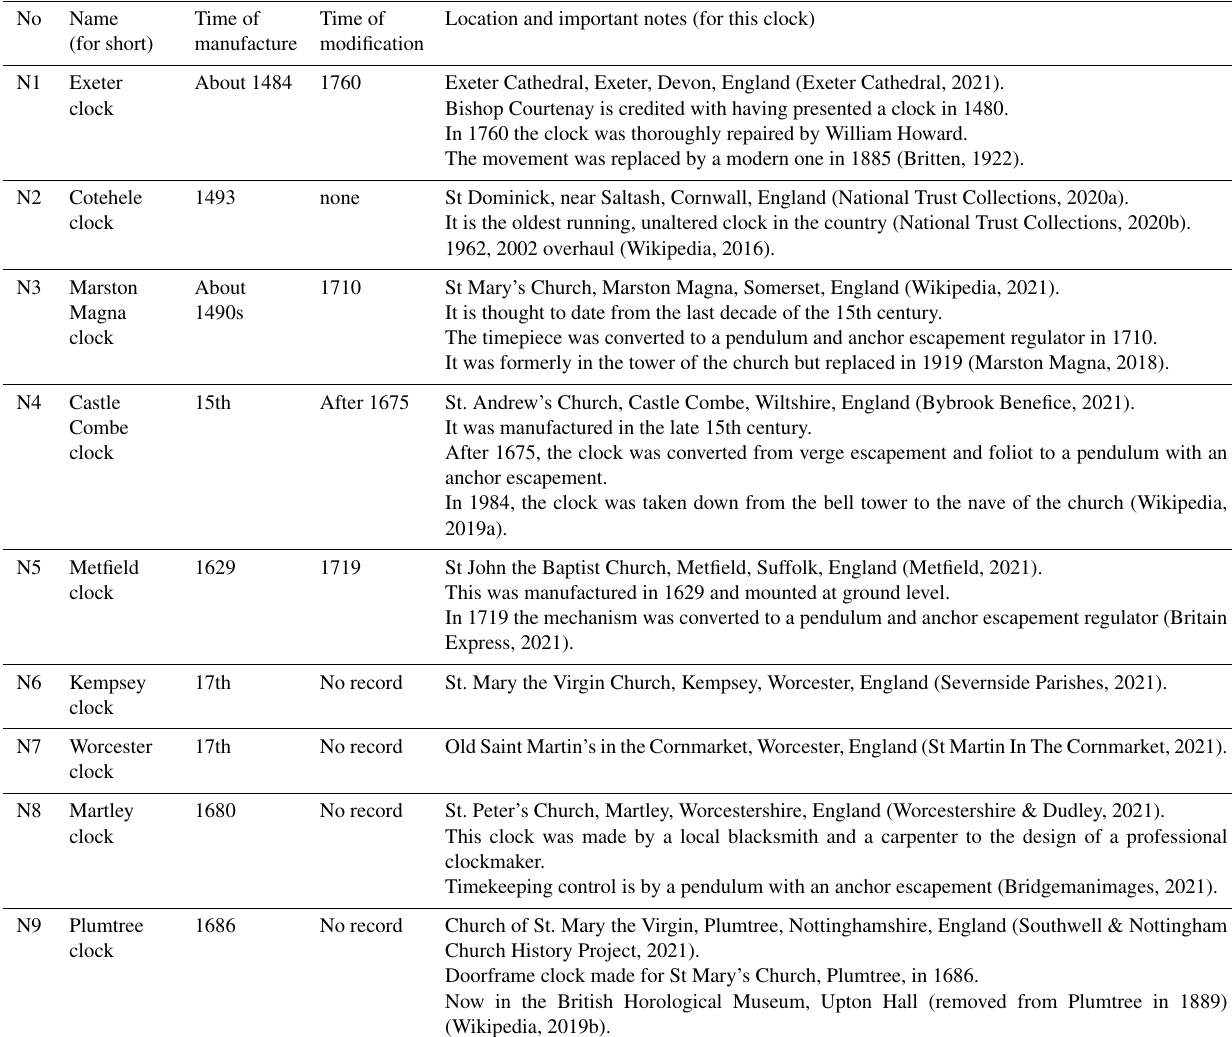
Table 1. Basic information of the existing representative vertically arranged mechanical turret